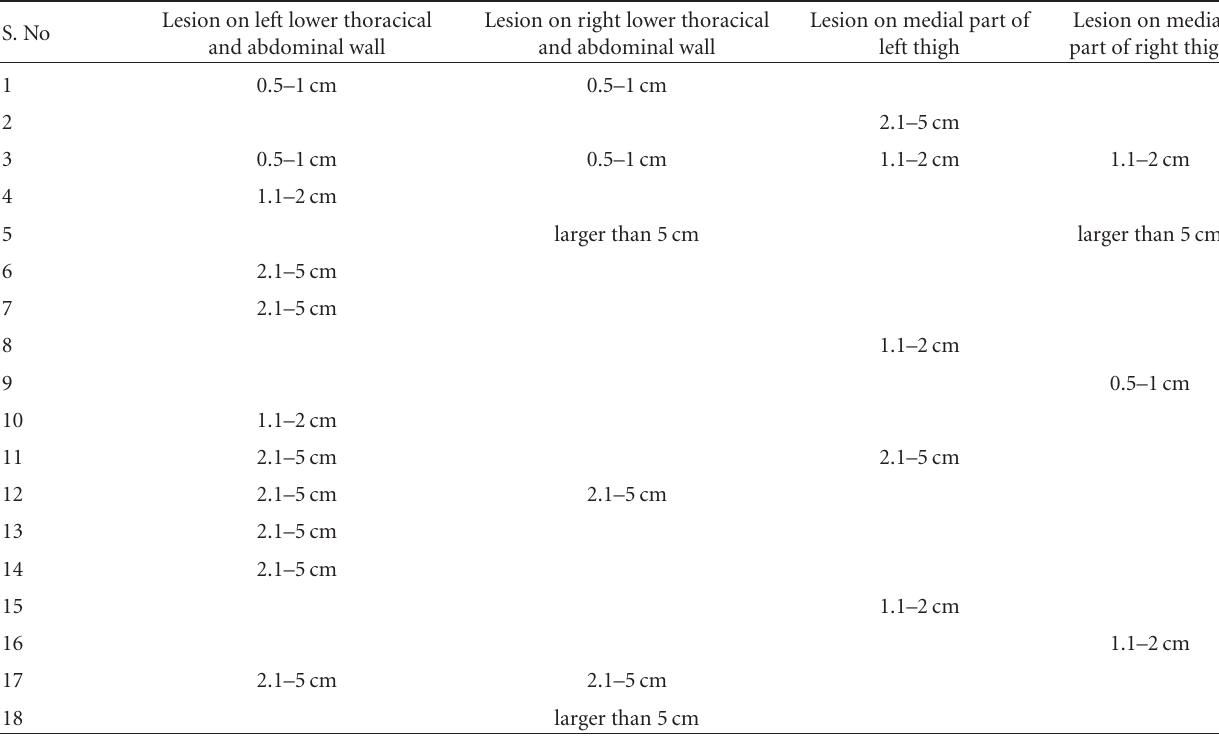
Table 1: Location and diameter of cutaneous lesions.